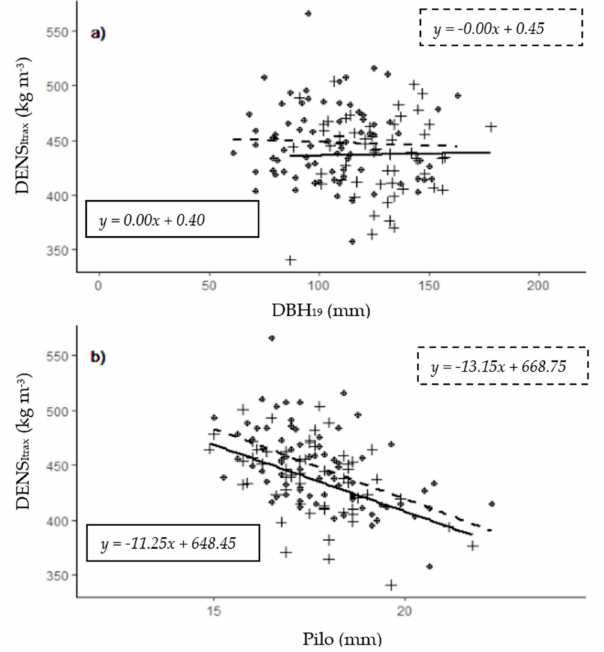
Figure 3. Relationship between diameter at age 19 ( a ) or Pilodyn penetration ( b ) with average wood density from Itrax at Hyssna (cross, solid line) and Brunsberg (circle, dashed line). Trend line equations are displayed for Hyssna (solid border) and Brunsberg (dashed